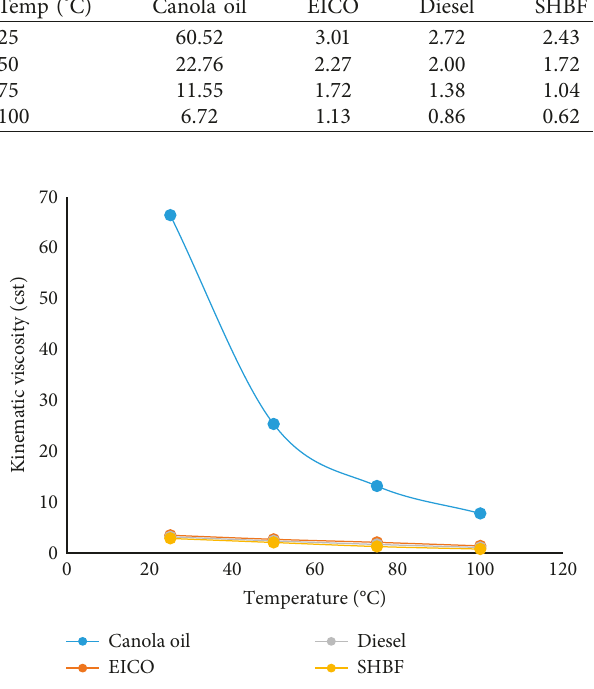
Figure 3: Kinematic viscosity variation with temperature.